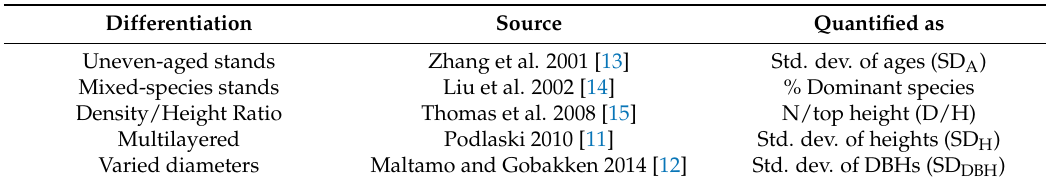
Table 4. Published predictors of multimodal diameter distributions and how they are used to classify bimodal plots. DBH, diameter at breast height.